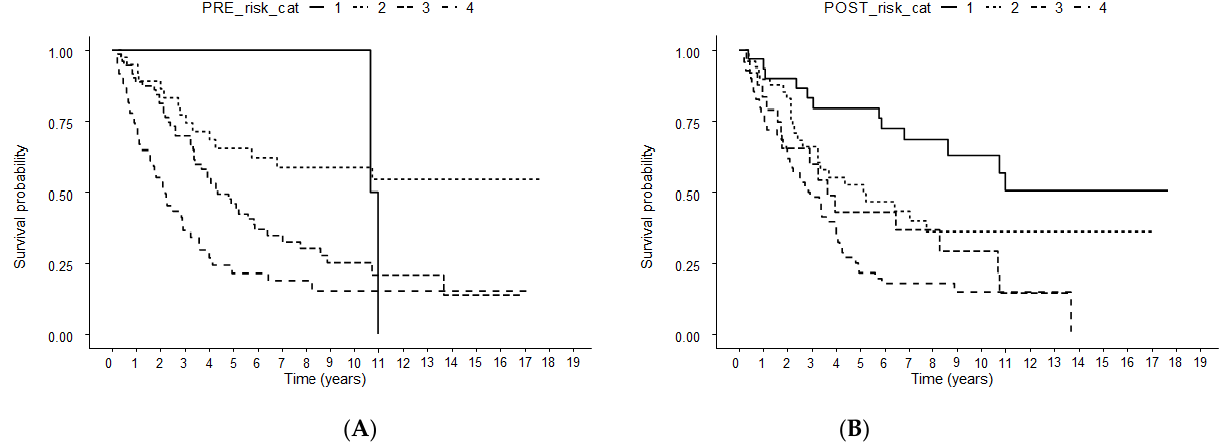
Figure 3. Kaplan-Meier curves according to stratification by Pre- ( A ) and Post-TACE-Predict ( B ) score. TACE, transarterial chemoembolization.